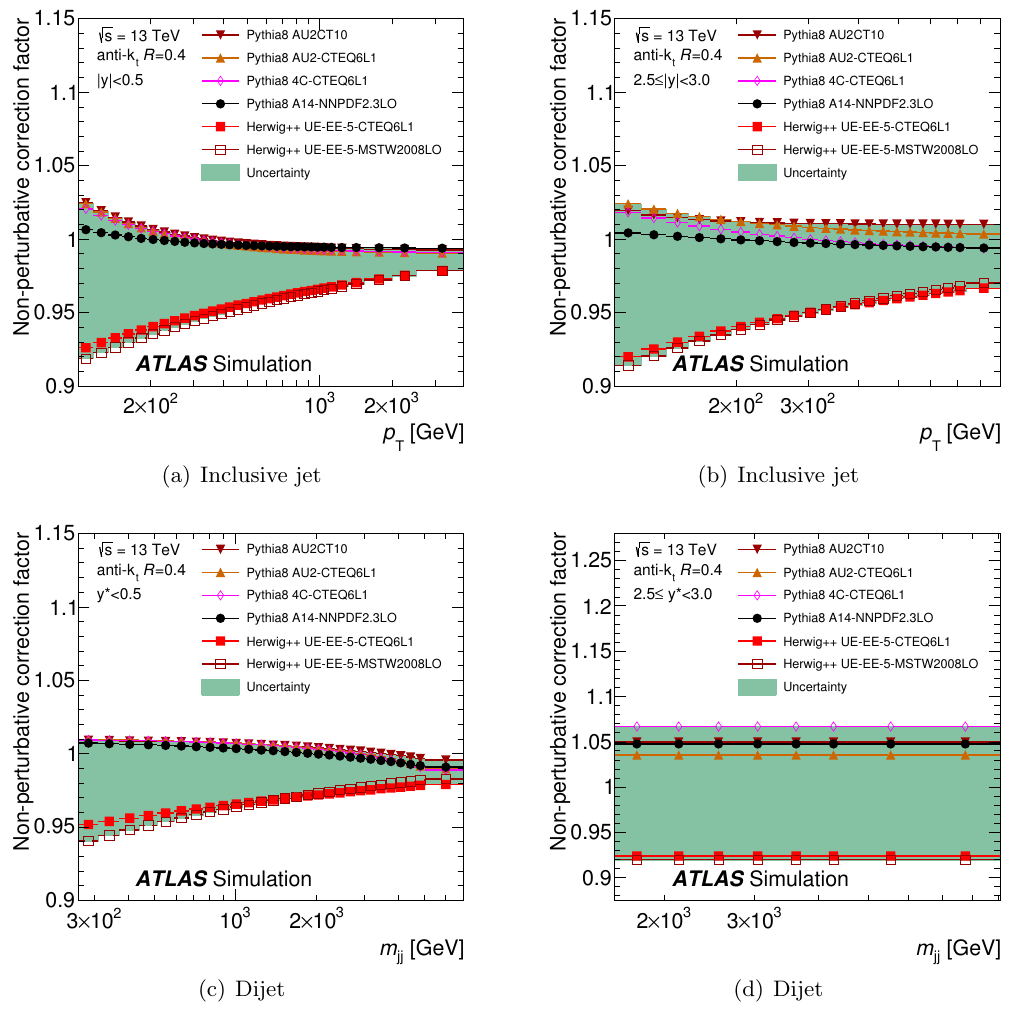
Figure 3 . Non-perturbative correction factors for the (inclusive jet, dijet) NLO pQCD prediction as a function of (jet p T , m jj ) for ((a), (c)) the (cid:12)rst (rapidity, y (cid:3) ) bin and for ((b), (d)) the last (rapidity, y (cid:3) ) bin. The corrections are derived using Pythia 8 with the A14 tune with the NNPDF2.3 LO PDF set. The envelope of all MC con(cid:12)guration variations is shown as a